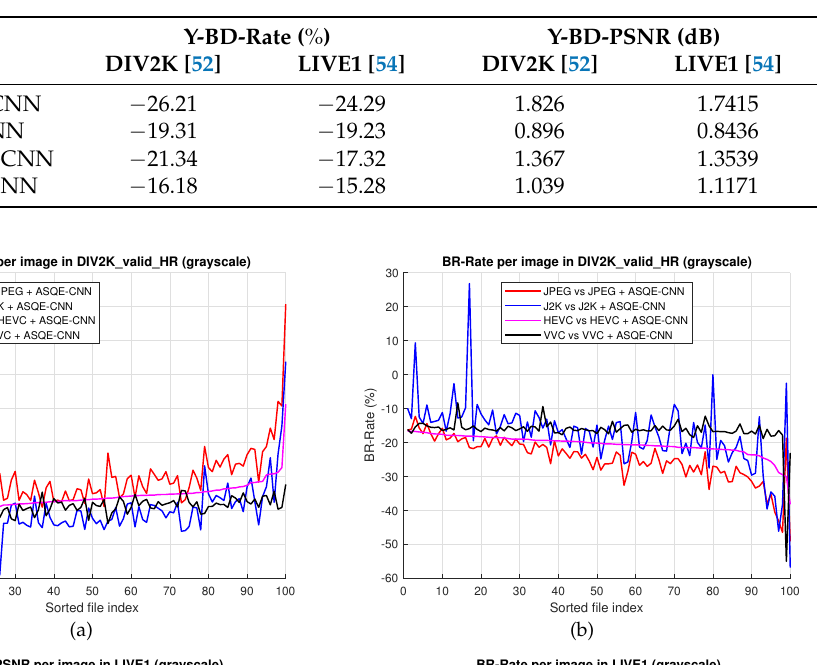
Table 5. Average Bjøntegaard metrics for grayscale images.